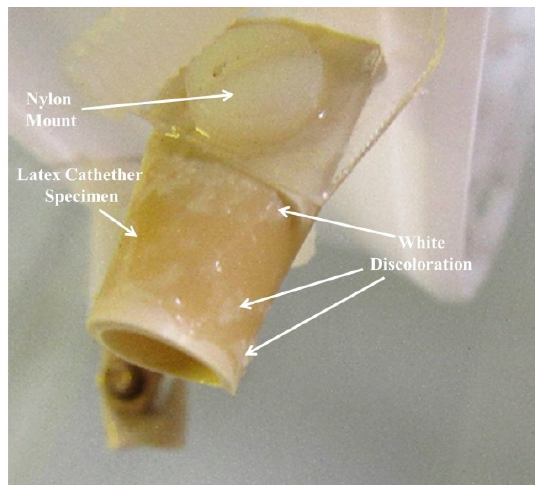
Figure 1. Control sample 0 (from trial #1) shows areas of white discoloration that may be associated with surface wetting.